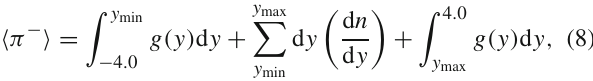
Fig. 12 The inverse slope parameter T of the transverse mass spectra as a function of rapidity divided by the beam rapidity. The fit range is 0 . 24 < m T − m π < 0 . 72 GeV. Statistical uncertainties are usually smaller than the marker size and systematic uncertainties are indicated by shaded